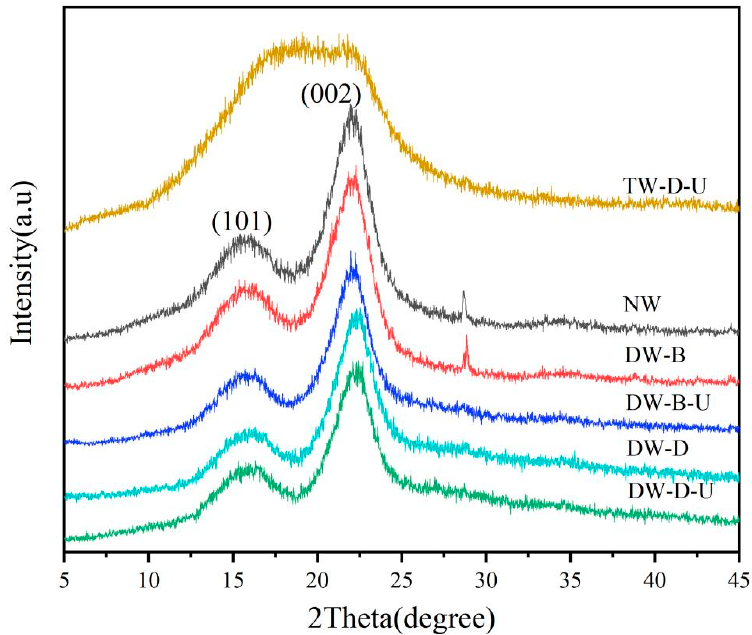
Figure 3. XRD images of natural wood (NW), four groups of delignified wood DW-B, DW-B-U, DW- D, DW-D-U and “transparent wood” TW-D-U. DW-D, DW-D-U and “transparent wood”